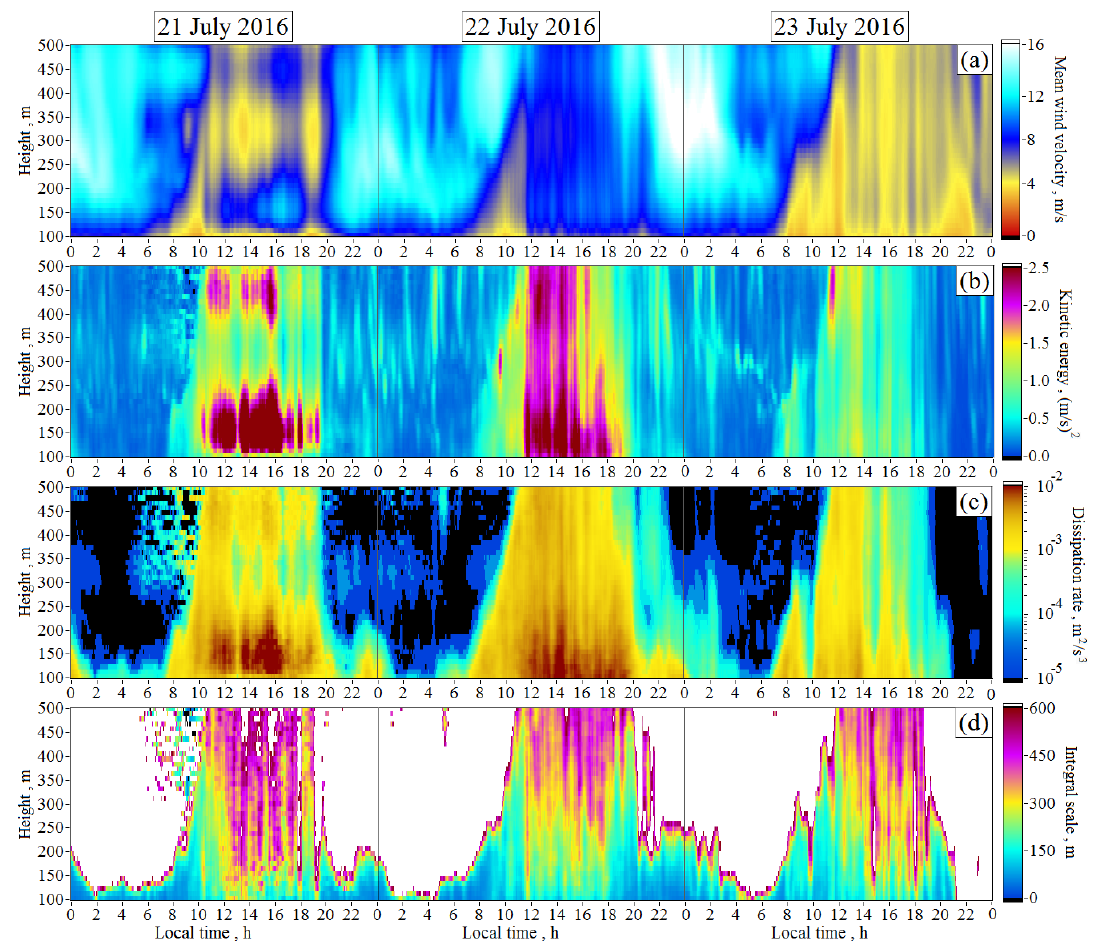
Figure 1. Spatiotemporal distributions of the mean velocity ( a ), kinetic energy of turbulence ( b ), dissipation rate of the kinetic energy of turbulence ( c ), and outer scale of turbulence ( d ) as obtained from the data of continuous measurements by the StreamLine lidar at the Basic Experimental Observatory of the Institute of Atmospheric Optics (IAO) SB RAS on 21–23 July 2016. In figures ( c , d ), estimates ε < 5 × 10 − 5 m 2 /s 3 are shown by the black color, and estimates L V > 600 m are shown by the white